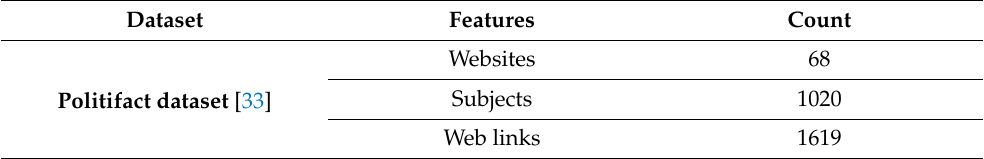
Table 3. PolitiFact dataset details.